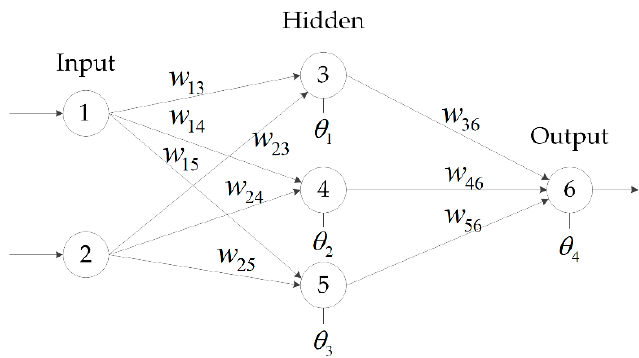
Figure 3. A small example of a multilayer perceptron (MLP) with a 2–3–1 structure.